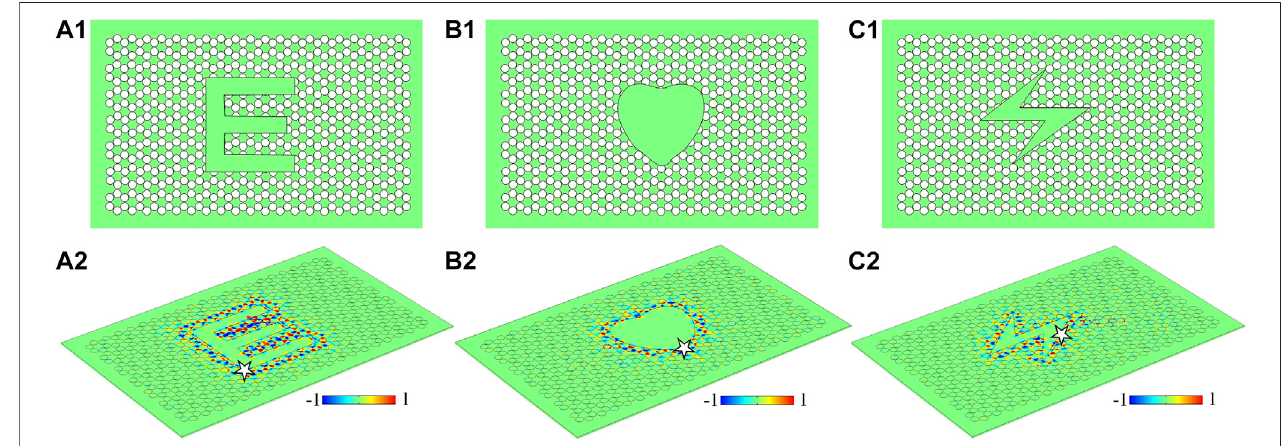
FIGURE 4 | Geometry-independent topological energy fl ux loop. (A) E-shaped loop. (B) Heart-shaped loop. (C) Lightning-shaped loop. (A1 – C1) Schematic diagrams. (A2 – C2) Electric fi eld distributions.